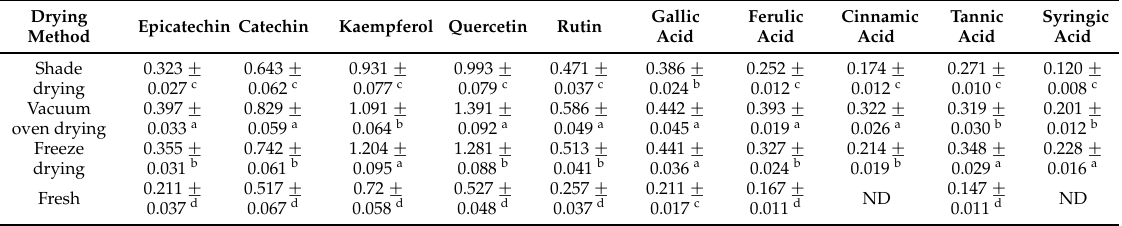
Table 2. Effect of different drying methods on individual flavonoids and phenolic acids content identified from Z. officinale var. rubrum rhizome